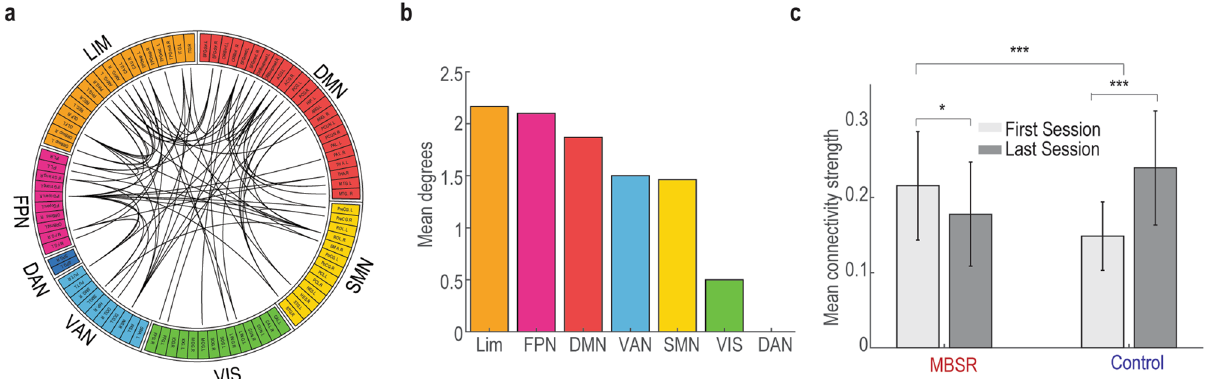
Figure 3. Meditation and learning interaction effects in the alpha band connectivity. ( a ) Significantly different network topographies identified by network based statistics. Each link represents a connection between two brain regions. ( b ) Network summary of ( a ) by parceling the connections into seven well-characterized resting- state networks. The mean degree is the averaged number of links within the seven networks. ( c ) Changes of mean connectivity strength within the identified network in ( a